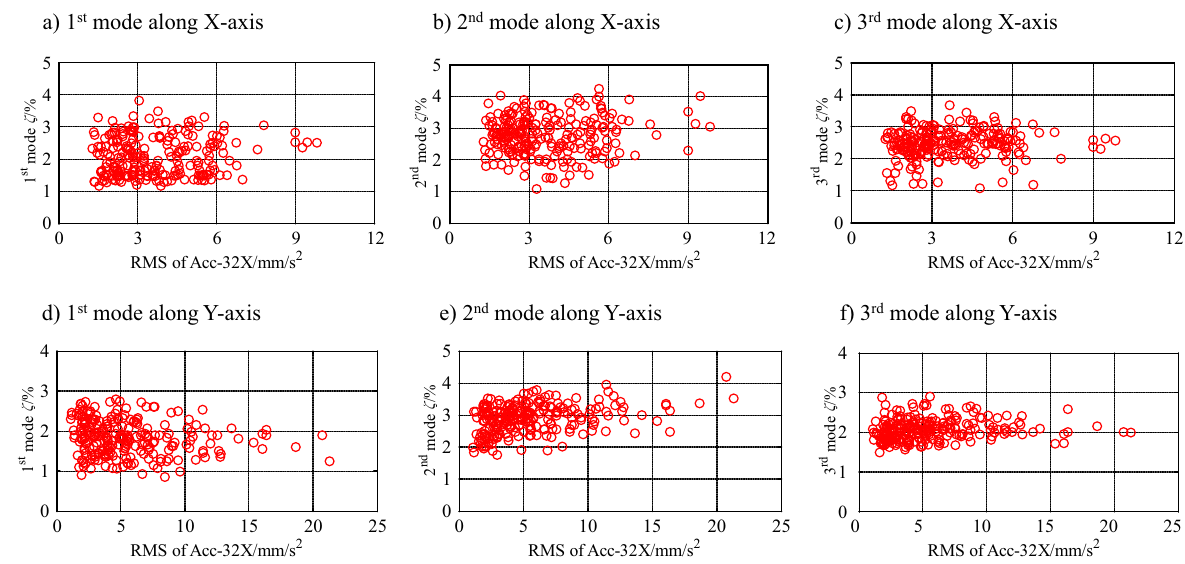
Figure 18. The relationship between modal damping ratios and RMS of Acc at the top